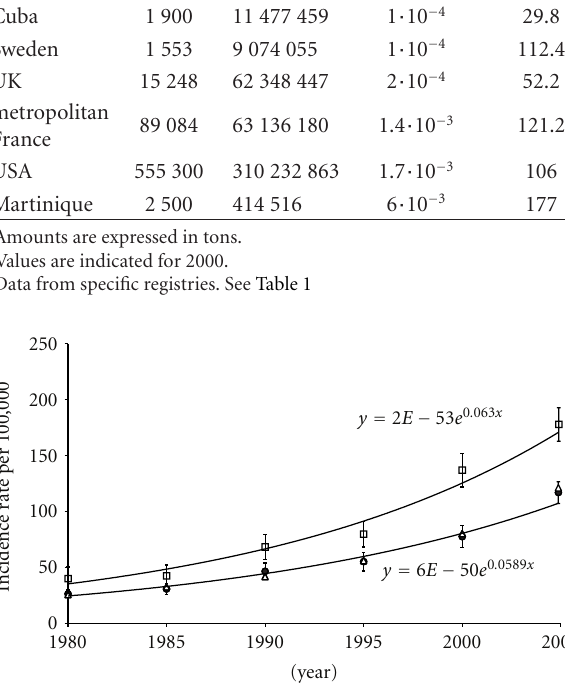
Figure 1: Evolution of prostate cancer incidence rates expressed as ASRs in Martinique (cid:2) in comparison with the incidence growth curve obtained from the 11 “department” registries of metropolitan France • and with the extrapolated overall incidence growth curve for metropolitan France (cid:3) . Values of R 2 were 0.9742 for Martinique and 0.9845 for the 11 metropolitan “department” registries. Note that for Martinique and metropolitan France, despite the fact they are seemingly diverging since 1985, after log transformation, the 2 curves are not significantly diverging (see Figure 2).